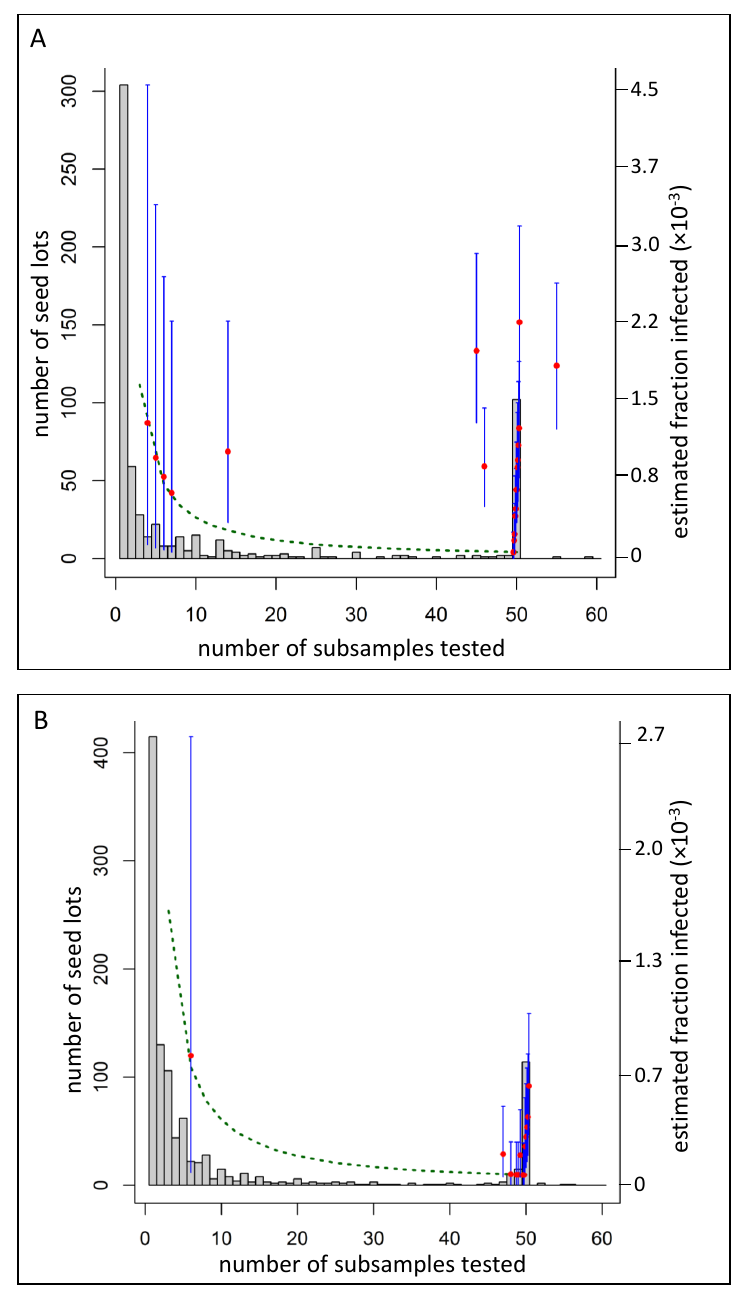
Figure 5. Estimates of the fraction of infected seeds (red points) in PSTVd-infected seed lots detected by the EMAI ( a ) and CHS ( b ) laboratories. The size of the seed lots ( x -axis) is represented by the numbers of subsamples tested from the lot. Credible intervals (blue bars) and the minimum possible best estimates given the number of subsamples tested (green dotted line) are shown. Seed lots ( x -axis) were bi-modally distributed in terms of sizes (grey bars): many lots were comprised of either fewer than 4000 seeds (<=2 subsamples) or 100,000 seeds or more (50 or more